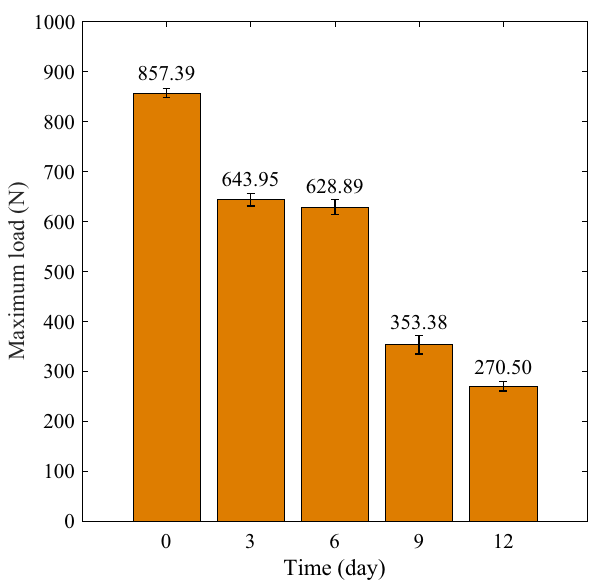
Figure 16: Maximum load of samples exposed to an acidic solution at 90°C.